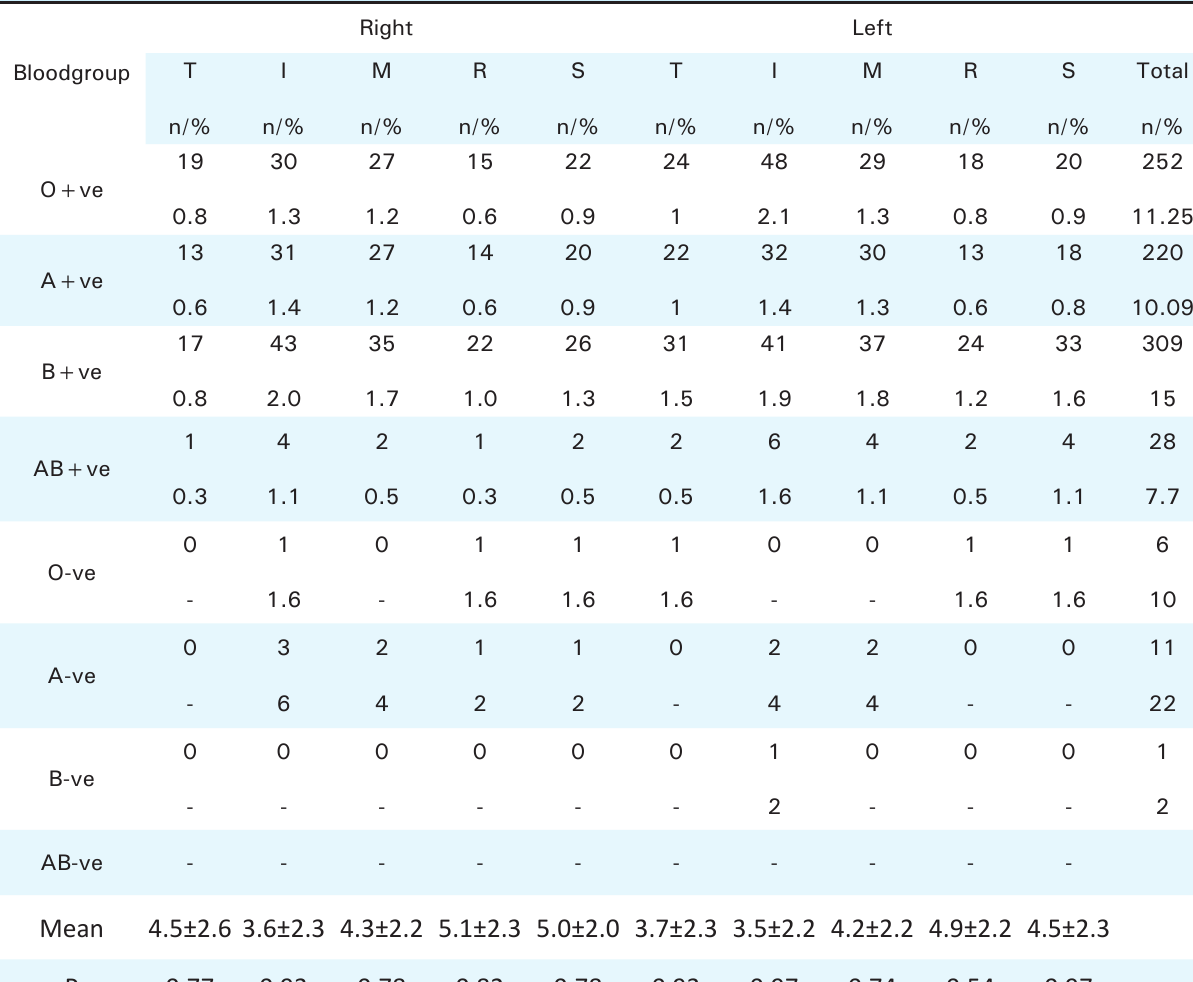
Table 5. Arch distribution and its mean comparison in individual fingers with the blood groups.